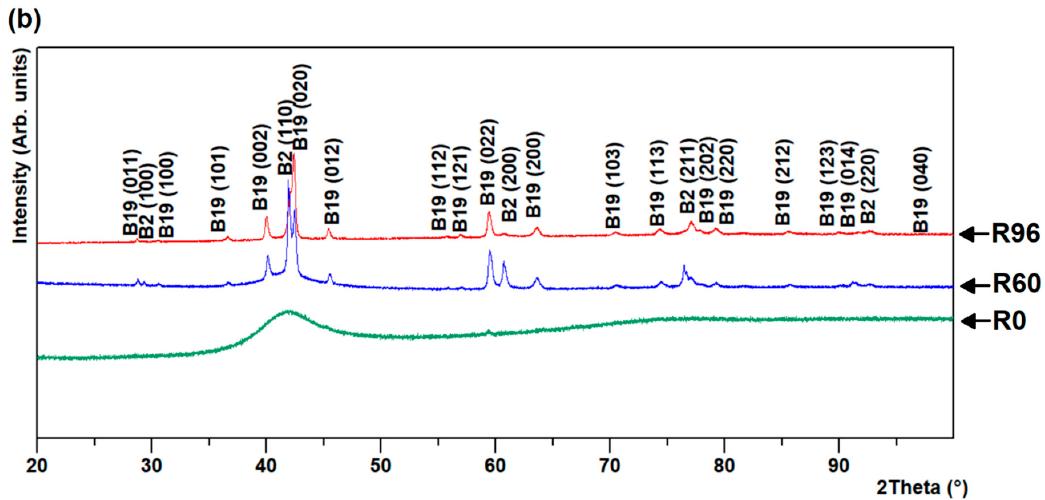
Figure 1. XRD scans of ( a ) air- and ( b ) wheel-side in R0, R60, and R96 ribbons.